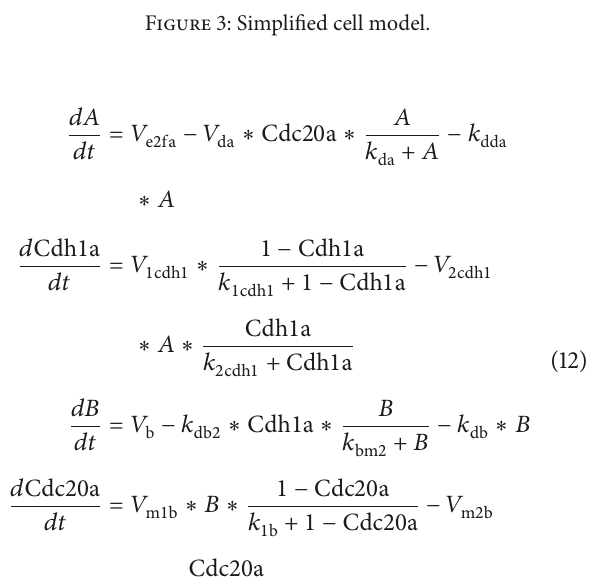
Figure 3: Simplified cell model.